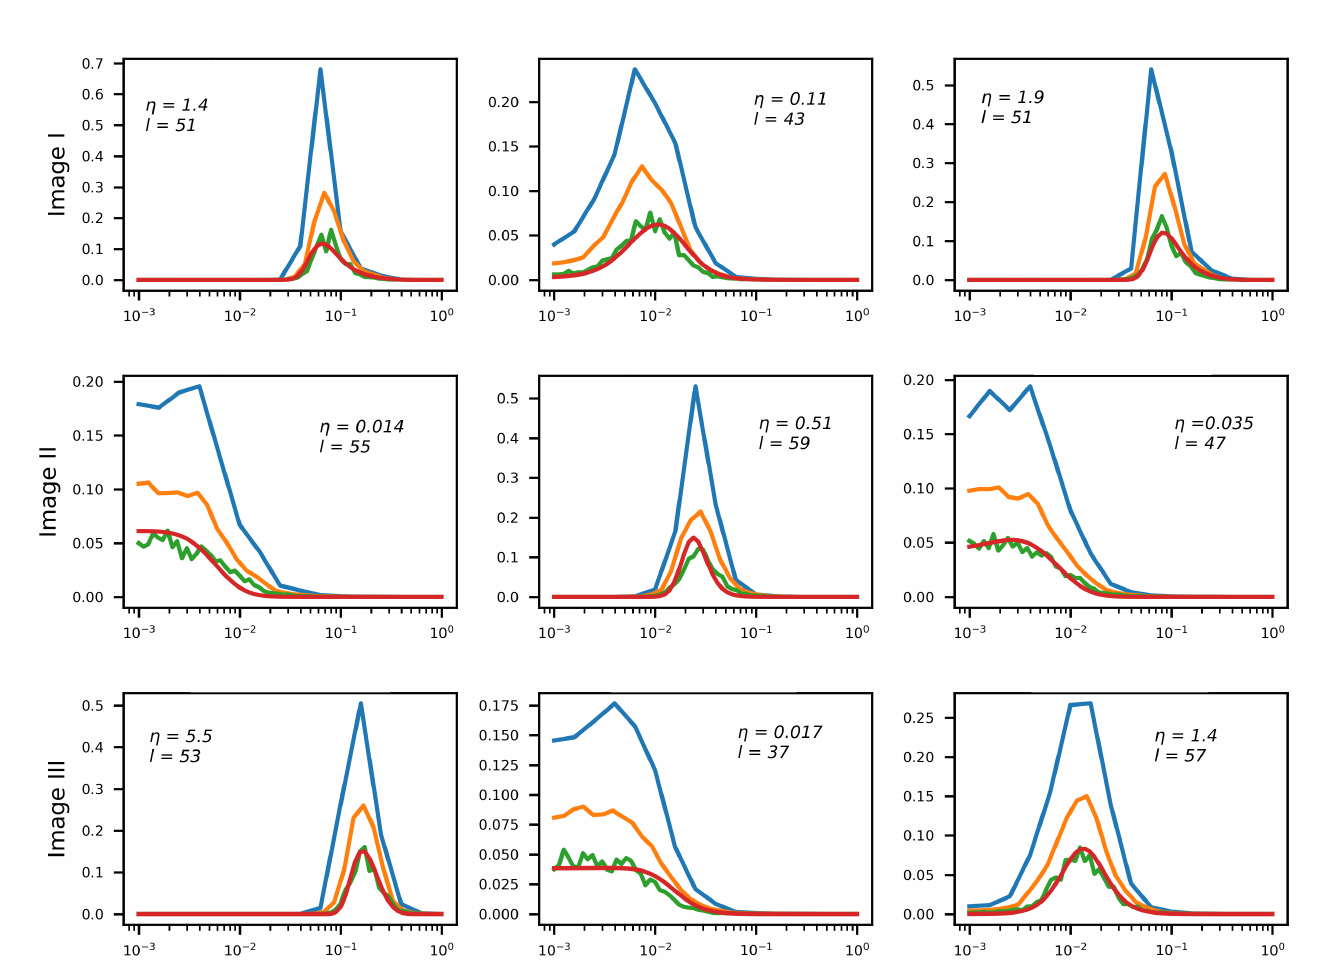
Figure 12. λ -weight array generation for various levels of input blur and noise (1D blur). Horizontal axis: λ values. Red Line: reference for 64 array entries. Blue/orange/green lines—generated arrays for 16/32/64 array entries,